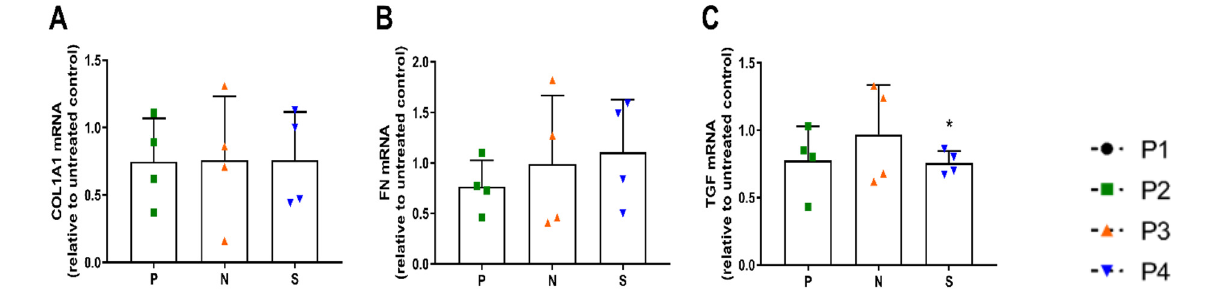
Figure 5. Effect of saracatinib treatment on fibrotic gene expression ( A ) COL1A1 expression, ( B ) FN expression and ( C ) TGF expression in HBE cells from IPF patients ( n = 4) after stimulation with pirfenidone (P, 1 mM), nintedanib (N, 0.1 µ M) and saracatinib (S, 1 µ M) for 24 h. The change in gene expression is expressed as a fold increase compared to the untreated control individually per IPF patient (* p < 0.05).